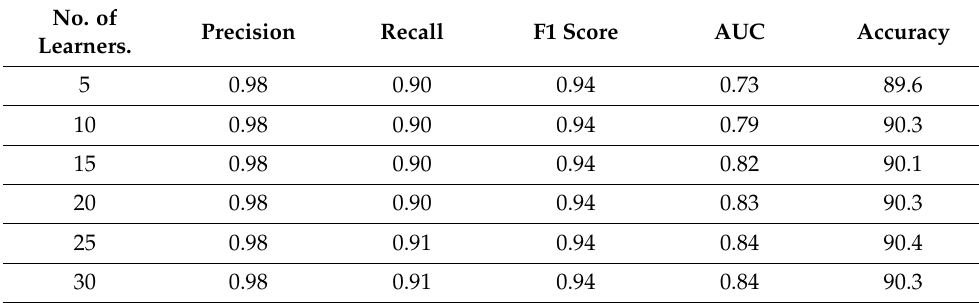
Table 6. Effect of the number of learners on various validation